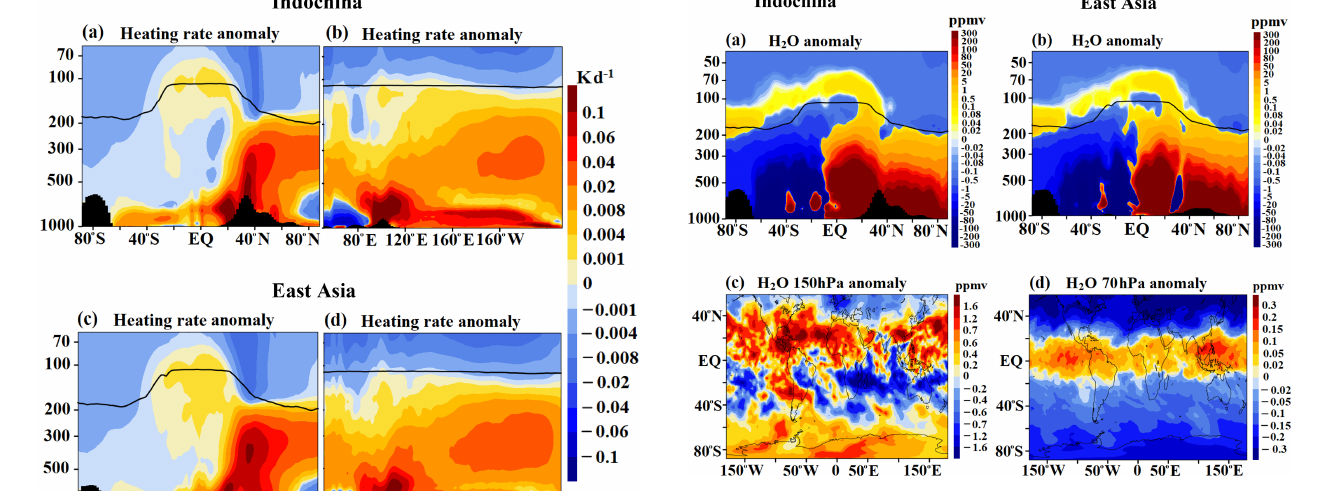
Figure 9. Vertical and horizontal distributions of anomalies of water vapor (ppmv) for spring 2013 from the ECHAM6–HAMMOZ sim- ulations (BMaeroon − BMaerooff); (a) latitude–pressure cross sec- tion averaged for 91–107 ◦ E and (b) longitude–pressure cross sec- tion averaged over 108–123 ◦ E, at (c) the 150hPa level and (d) the 70hPa level. In (a) – (b) the black vertical bars show the topography, and the black line indicates the